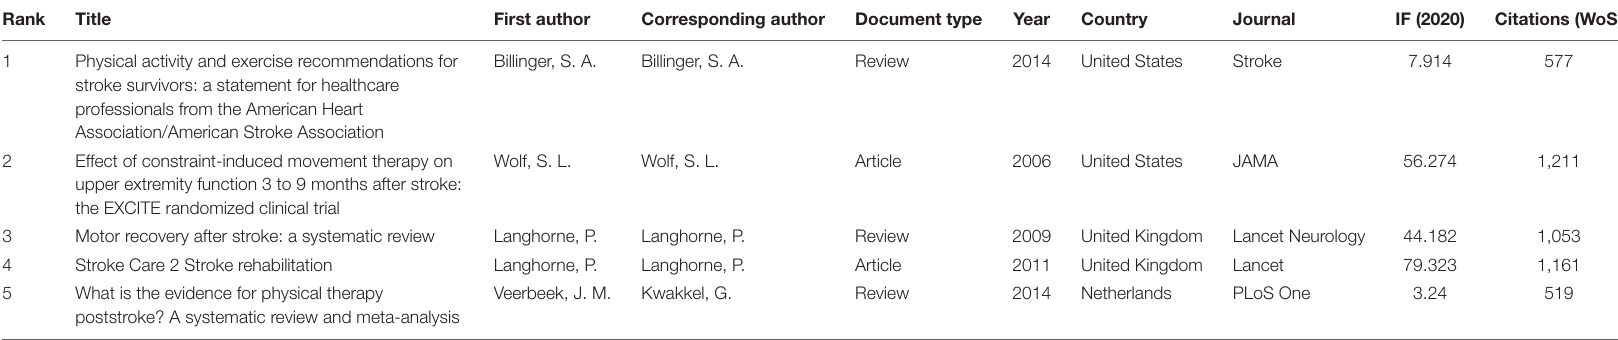
TABLE 3 | The top five references based on the number of citations.